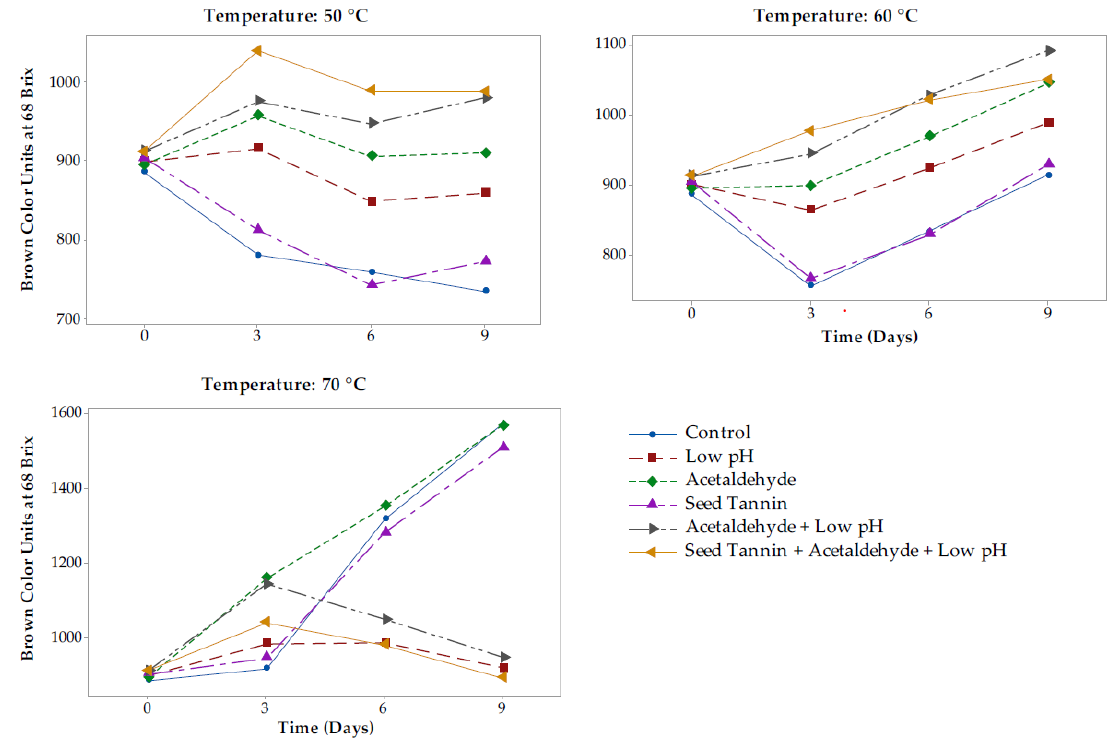
Figure 3. Effect of seed tannin, low pH, and acetaldehyde on brown color evolution in Rubired concentrate from conventional must heating (CMH) at different temperatures. All data normalized to 68 °Brix.